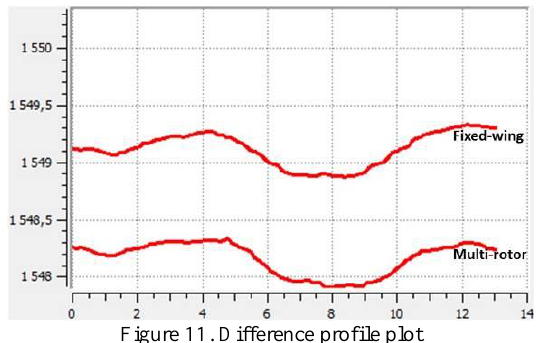
Figure 11. Difference profile plot